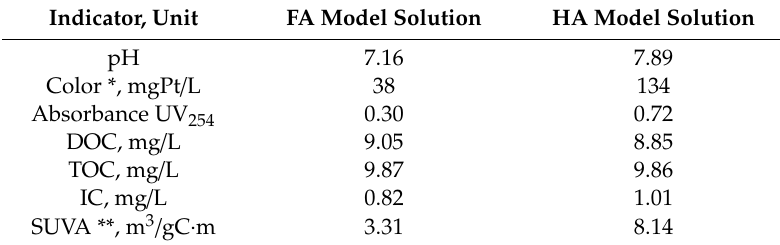
Table 3. Characteristics of the model solutions investigated.